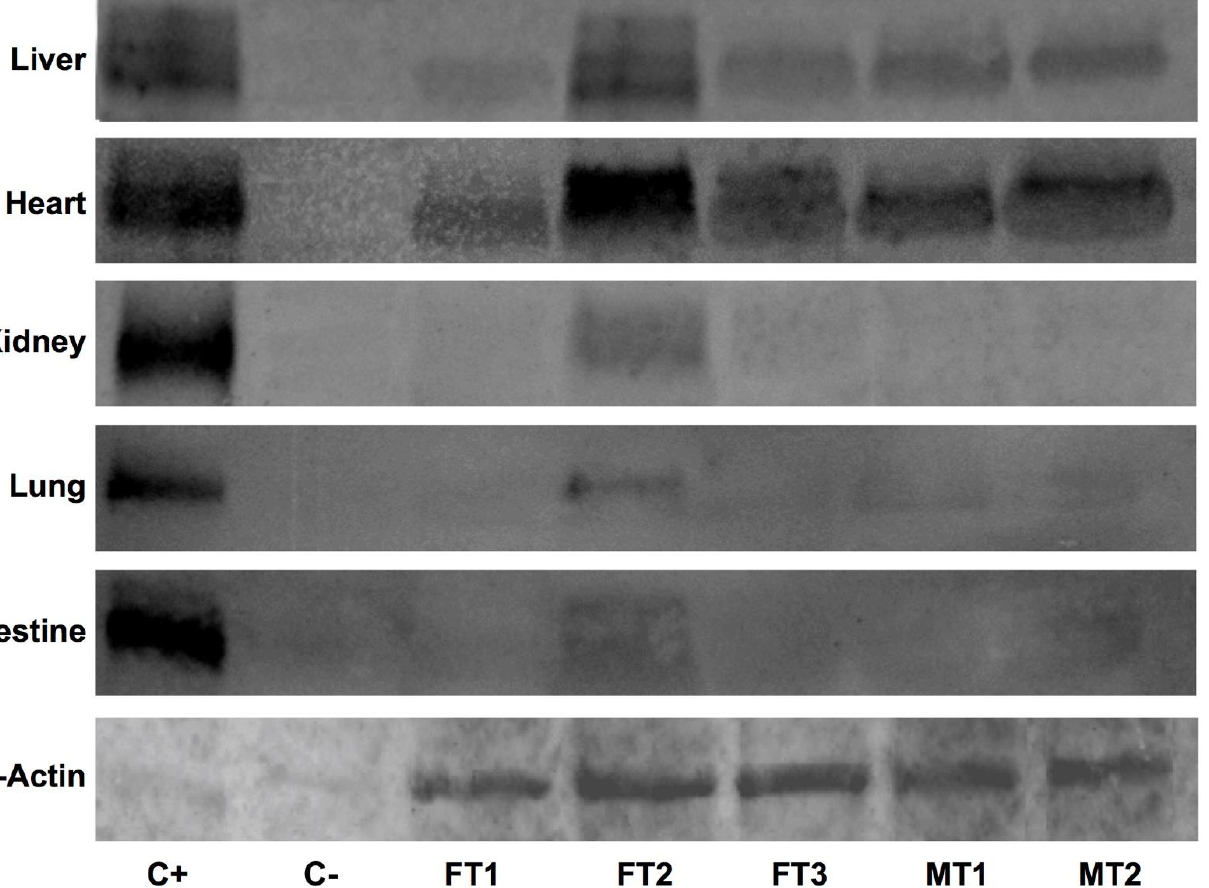
Figure 2. hDAF levels fluctuate when comparing same samples from different transgenic swine. (A) Detection by means of WB of hDAF levels in samples from liver, heart, kidney, lung and intestine from the noted individual specimens. The expression of porcine β -Actin protein in liver, as shown in the lower line, served as loading control. Similar loadings of protein samples from hCD55 -transfected HEK-293 cells and wild-type pigs were used as positive and negative controls, respectively. Images are representative of three different runs. The Full WB, please refer to the